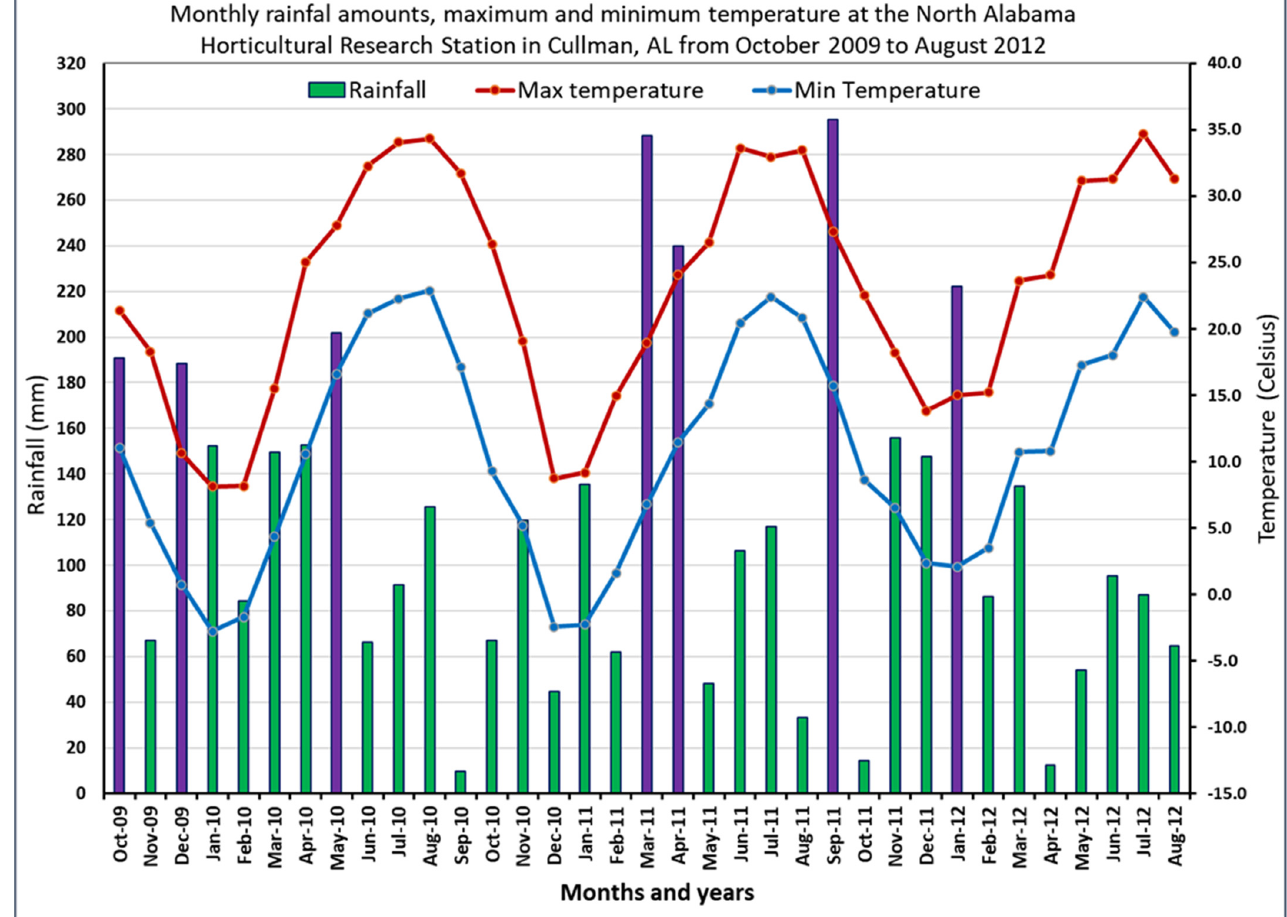
Figure 6. Monthly rainfall amounts (in mm) along with maximum and minimum temperatures in degrees Celsius during three growing seasons: October 2009 to August 2012 [27]. The purple color represents unusually high rainfall events that exceeded 190 mm of rainfall.